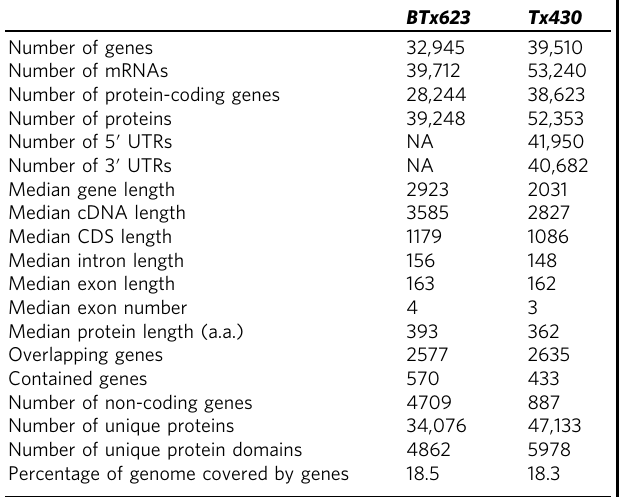
Table 3 Annotation comparison